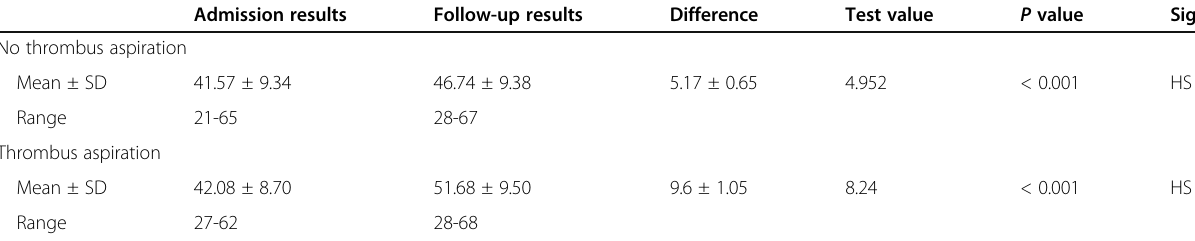
Table 6 Statistical significant results regarding improvement of LV systolic function in both 2